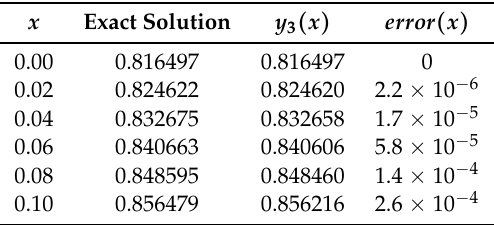
Table 1. Error when α =